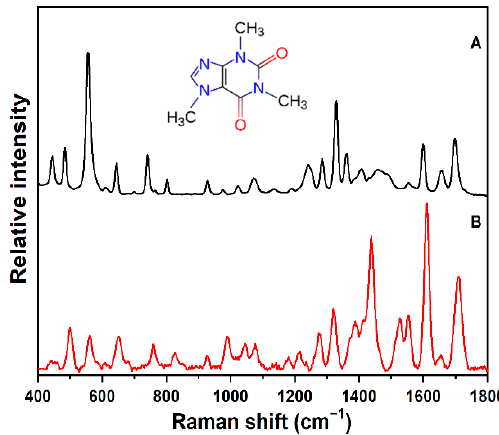
Figure 2. ( A ) Raman spectra of caffeine powder (with structure of caffeine shown) from commercial Nicolet spectral library, FT-Raman, 500 mW at 1064 nm with 4 cm − 1 resolution. ( B ) SERS of caffeine, measured at 100 ppm in ultrapure water, in SERS-active gold sol–gel capillaries, on portable desktop dispersive Raman unit, 187.5 mW at 785 nm laser excitation, acquisition 300 ms with 4× averaging. The spectra were normalized to account for the different responses between the two Raman instruments (where the intensities of the dominant Raman peak at 556 cm − 1 and the SERS peak at 1609 cm − 1 were set to 1.0) and then offset for clarity. Table 1. The observed peaks in the Raman and SERS spectra and their vibrational assignments. Raman bands were assigned according to the literature, and SERS bands were tentatively assigned to corresponding NR features. Raman (cm − 1 ) SERS (cm − 1 ) ∆ (cm − 1 ) Vibrational Assignments 445 s 442 w − 3 N-C-C deformation +16 C-N-C deformation O=C-N deformation (or pyridine ring +1 0 o.p. CH